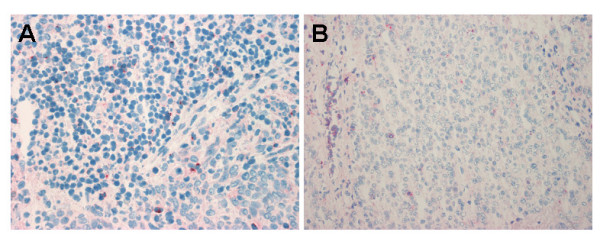
Immunohistochemical detection (on frozen tissue sections) of CD40L+ cells within UNPC microenvironment. CD40L positivity is manifested as dot-like staining on isolated small lymphocytes. A. The figure shows a high content of CD40L+ lymphocytes, either intermingled with tumor cells or located around UNPC tumor nests, in a case (female, 37 years old) with high serum levels of sCD40L. B. The figure shows few CD40L+ lymphocytes in a case (male, 34 years old) with a low content of sCD40L. Original magnification ×250.